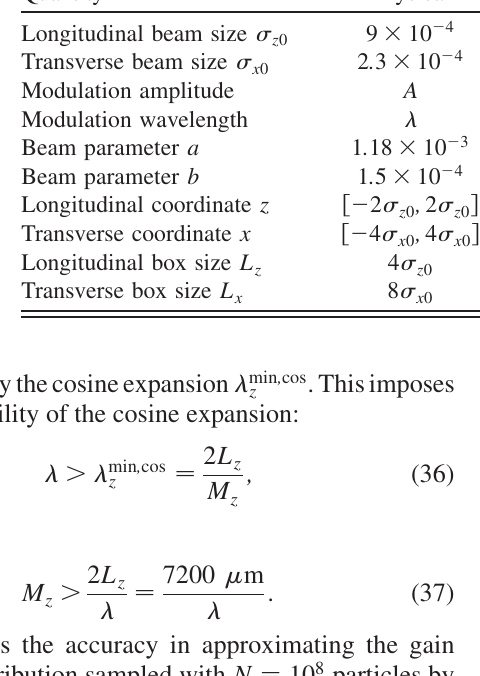
TABLE II. Dimensional and nondimensionalized parameters of the simulation.